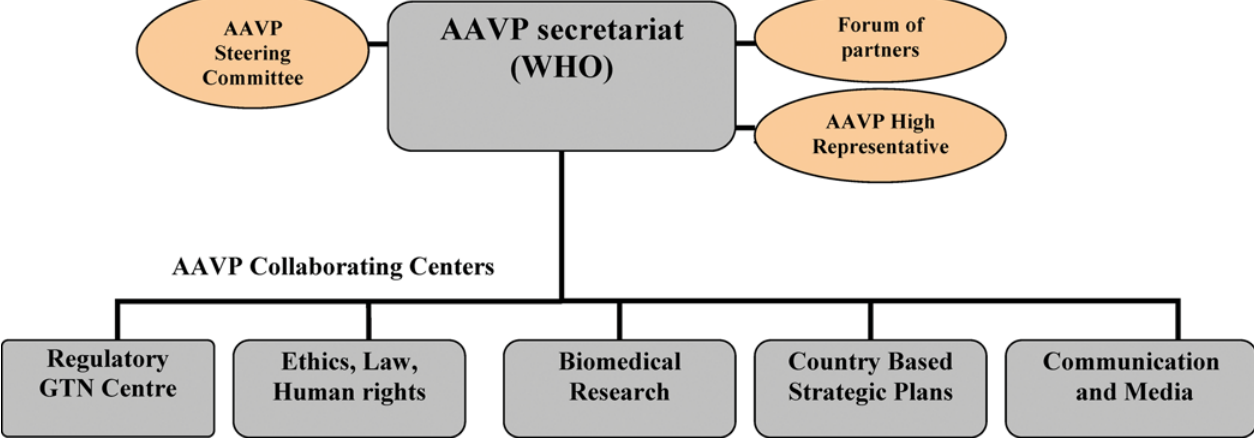
Figure 1. The AAVP Structure GTN, Global Training Network.